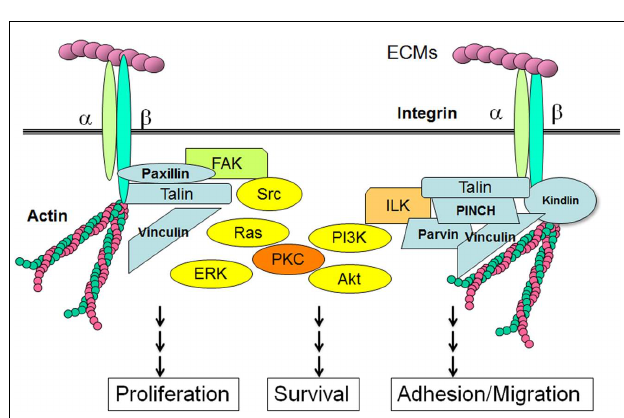
FIGURE 3 | Integrins, adaptor proteins, and signaling pathways. When ECMs bind to integrin receptors and form focal adhesions, the cytoplasmic tails of β -integrins are associated with a number of adaptor proteins.Talin forms a contact with both the β -integrin tail and the actin cytoskeleton. ILK associates with actin through its partners such as parvin, PINCH and kindling. FAK is responsible for the binding of integrin-associated proteins like paxillin and talin.These integrin-associated proteins involve non-receptor type kinases, such as Src, FAK, or ILK, which activate cellular transduction pathways, including the MAP kinase pathways, PI3K/Akt pathways and PKCs. Integrins are also associated with cytoskeletal proteins through the adaptor proteins, and can regulate cellular shape and